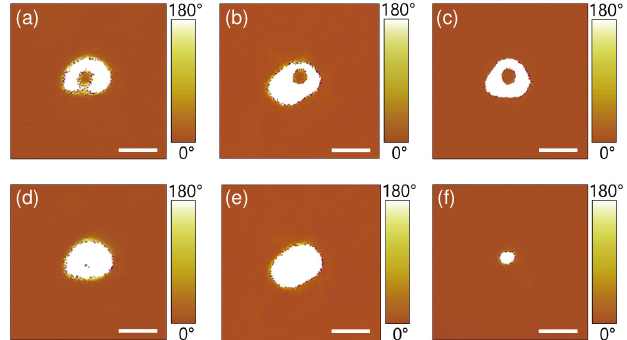
Figure 5. ( a – c ) The PFM images of the donut-shaped domains fabricated with the same step-1 poling field of U DC 1 = 40 V and t p 1 = 1 s. ( d – f ) The corresponding PFM images of domain structures after the step-2 poling with different pulse duration t p 2 = 0.8 ms, 1 ms and 16 ms, respectively. The magnitude of the step-2 poling field was set to be U DC 2 = − 52 V. Scale bar: 100